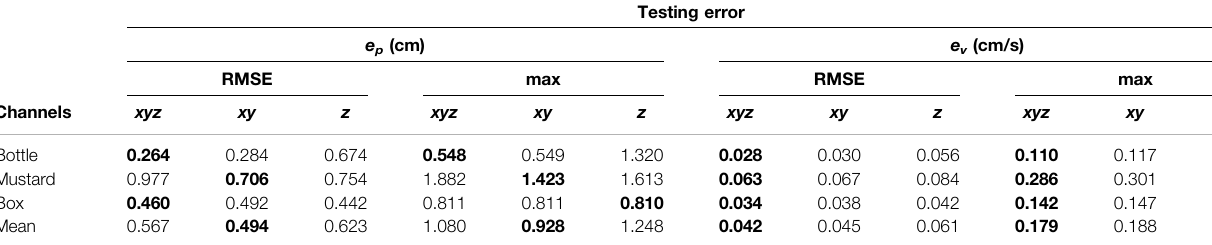
A bold entry indicates the best result among the available alternatives.